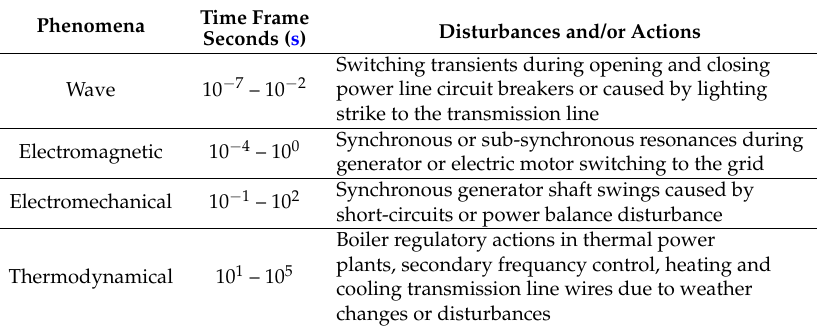
Table 1. Classification of power system transients and their time